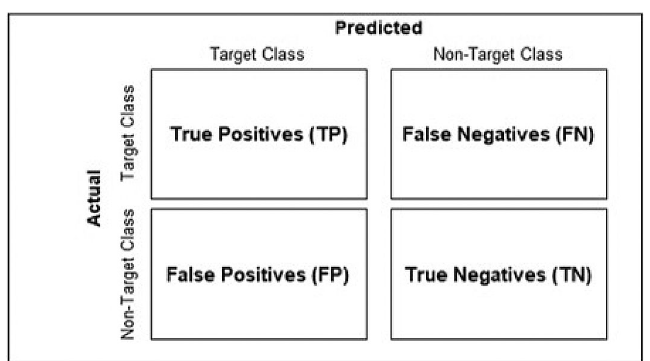
Figure 1. Format of a conventional classifier confusion